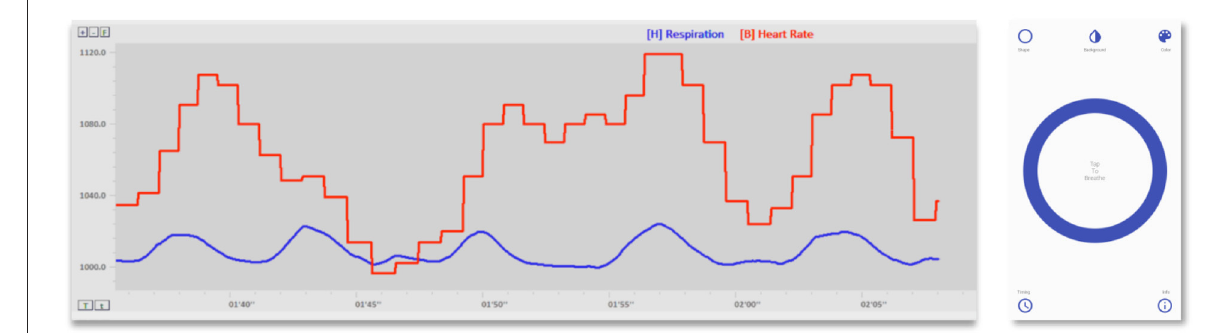
FIGURE1 Commercially available Heart Rate Variability Biofeedback (HRV-b) and Paced Breathing tools. (Left) Biotrace + Clinical HRV-b Software (Mind Media): Clinical populations align their breathing (blue) with a real-time representation of their heart rate (red), with the goal of creating smooth, large waves in their heart rate signal. (Right) Breathe Easy (Mood Tools): Users time their inhales and exhales with the rhythmic expansion and contraction of the onscreen circle (blue). This app employs a simple paced breathing protocol – users select a constant, predetermined breathing rate at the start of each